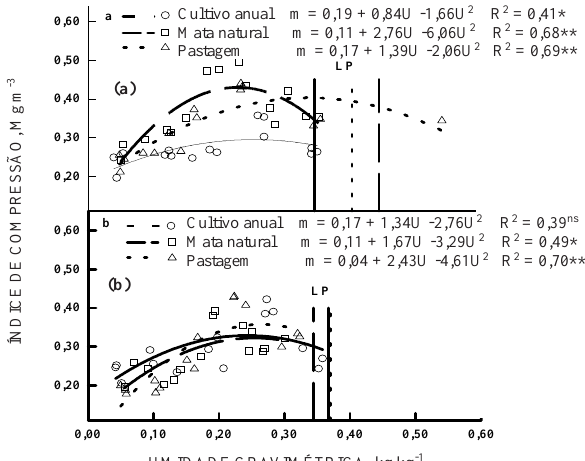
Figura 9. Relação entre a umidade gravimétrica (U) e o índice de compressão (m) para o Latossolo Vermelho-Escuro, sob cultivo anual, mata natural e pastagem cultivada, nas profundidades de 0-0,03 (a) e 0,27-0,30 m (b), com 15 repetições (a linha vertical representa o limite de plastici- dade (LP), com três repetições). *, **, ns significa- tivos a 5 e 1% e não-significativo,